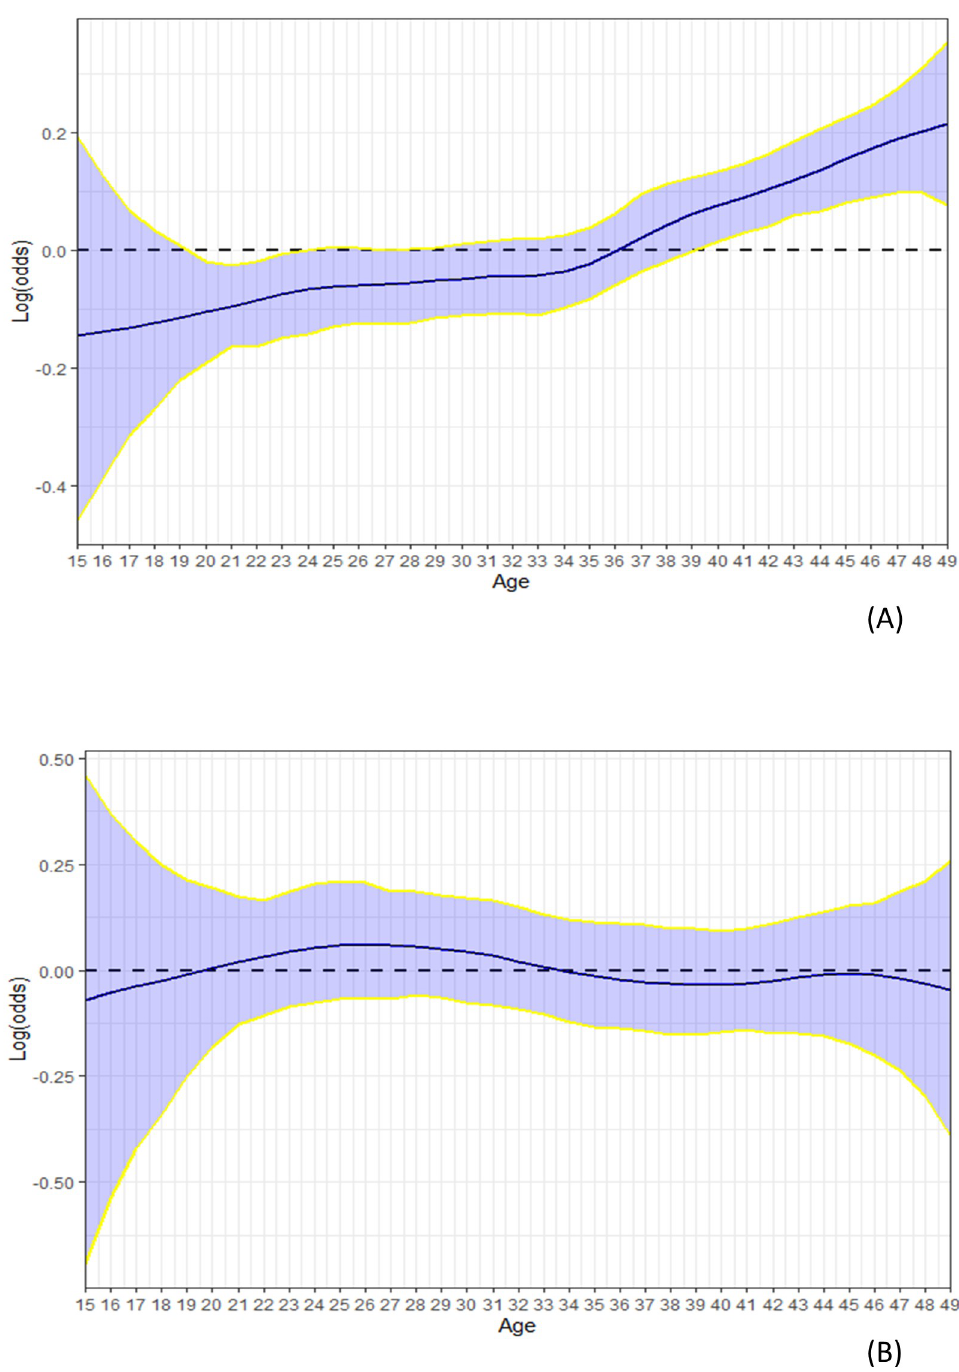
Fig 9. Non-linear effects (log-odds) of mother’s age on her daughter’s likelihood of being cut based on (A) m 6 of the pooled 2003 to 2016 data and (B) Model B of the 2016 MICS data. The blue lines are the posterior means; the yellow lines are the 95% credible intervals of the posterior estimates; and the blue band is the width of the 95% credible interval.